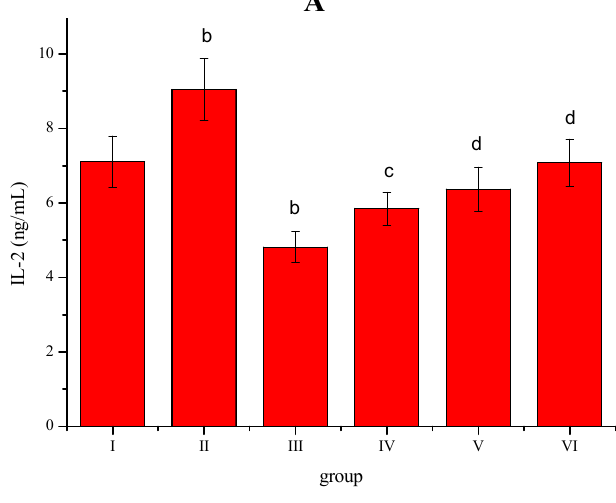
Figure 1. ( A ). Effect of Sargassum pallidum aqueous extract on serum IL-2, ( B ) IL-4 and ( C ) IL-10 levels in different